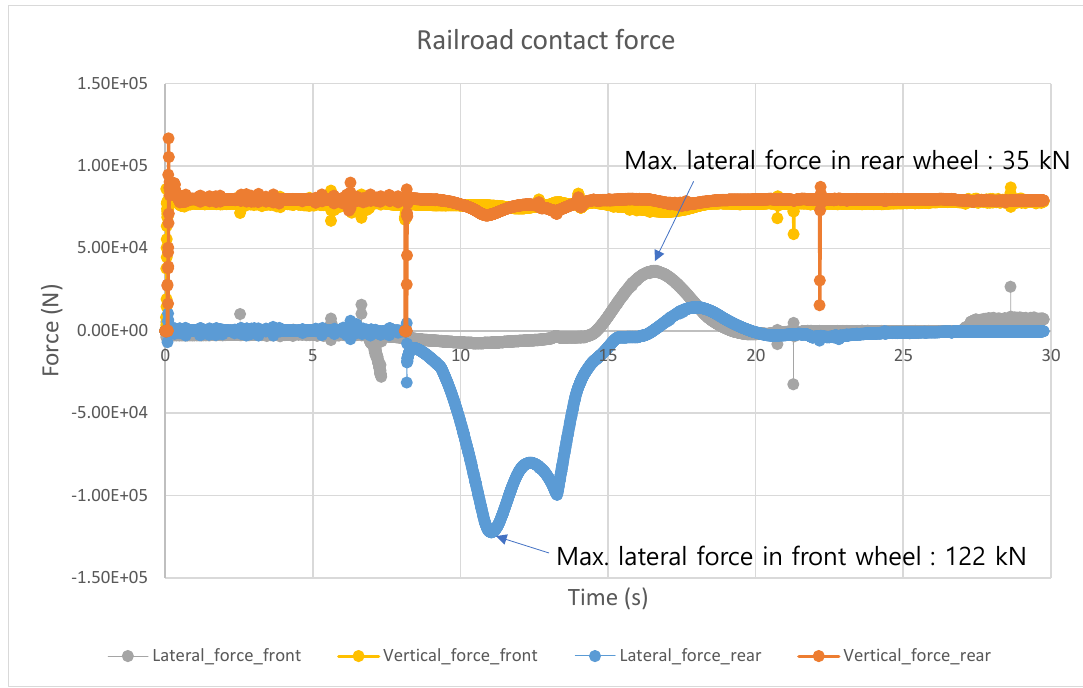
Figure 11. Multi-body dynamic analysis of the variable gauge bogie and the rail.